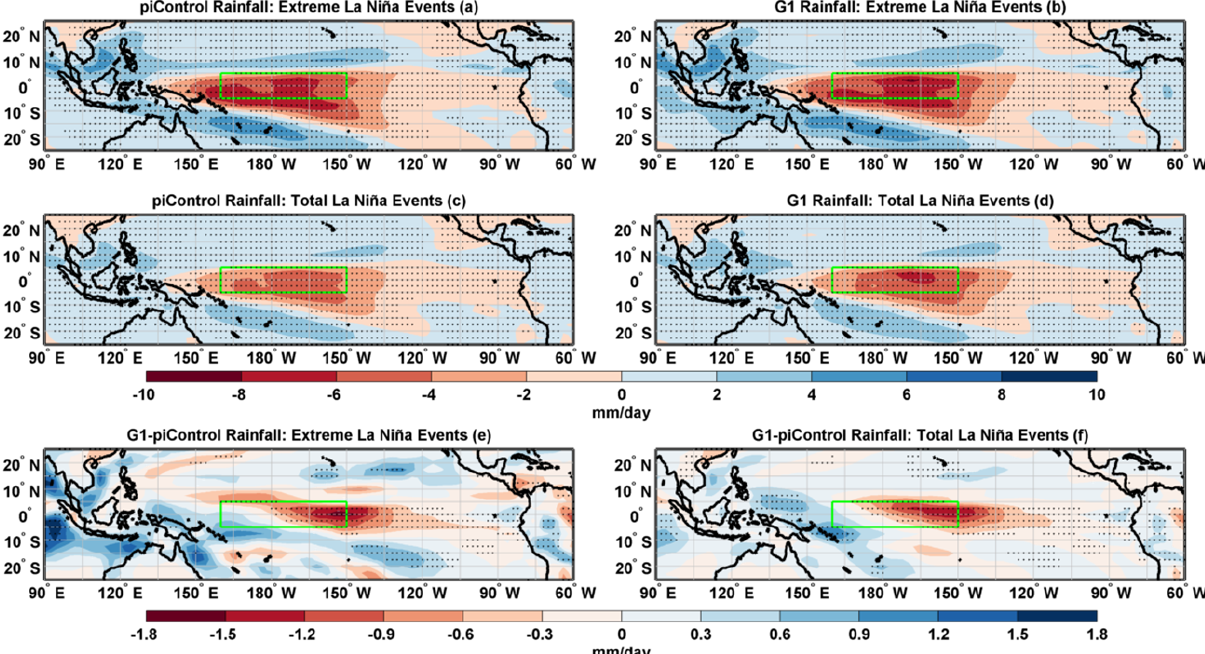
Figure 13. Composites of rainfall anomalies for extreme La Niña events in (a) piControl and (b) G1. Composites of rainfall anomalies for the total number of La Niña events in (c) piControl and (d) G1. Composite differences (G1 − piControl) of rainfall for (e) extreme La Niña events and (f) the total number of La Niña events. Stipples indicate grid points with statistical significance at 99%cl using a non-parametric Wilcoxon rank-sum test. The green box indicates the Niño4